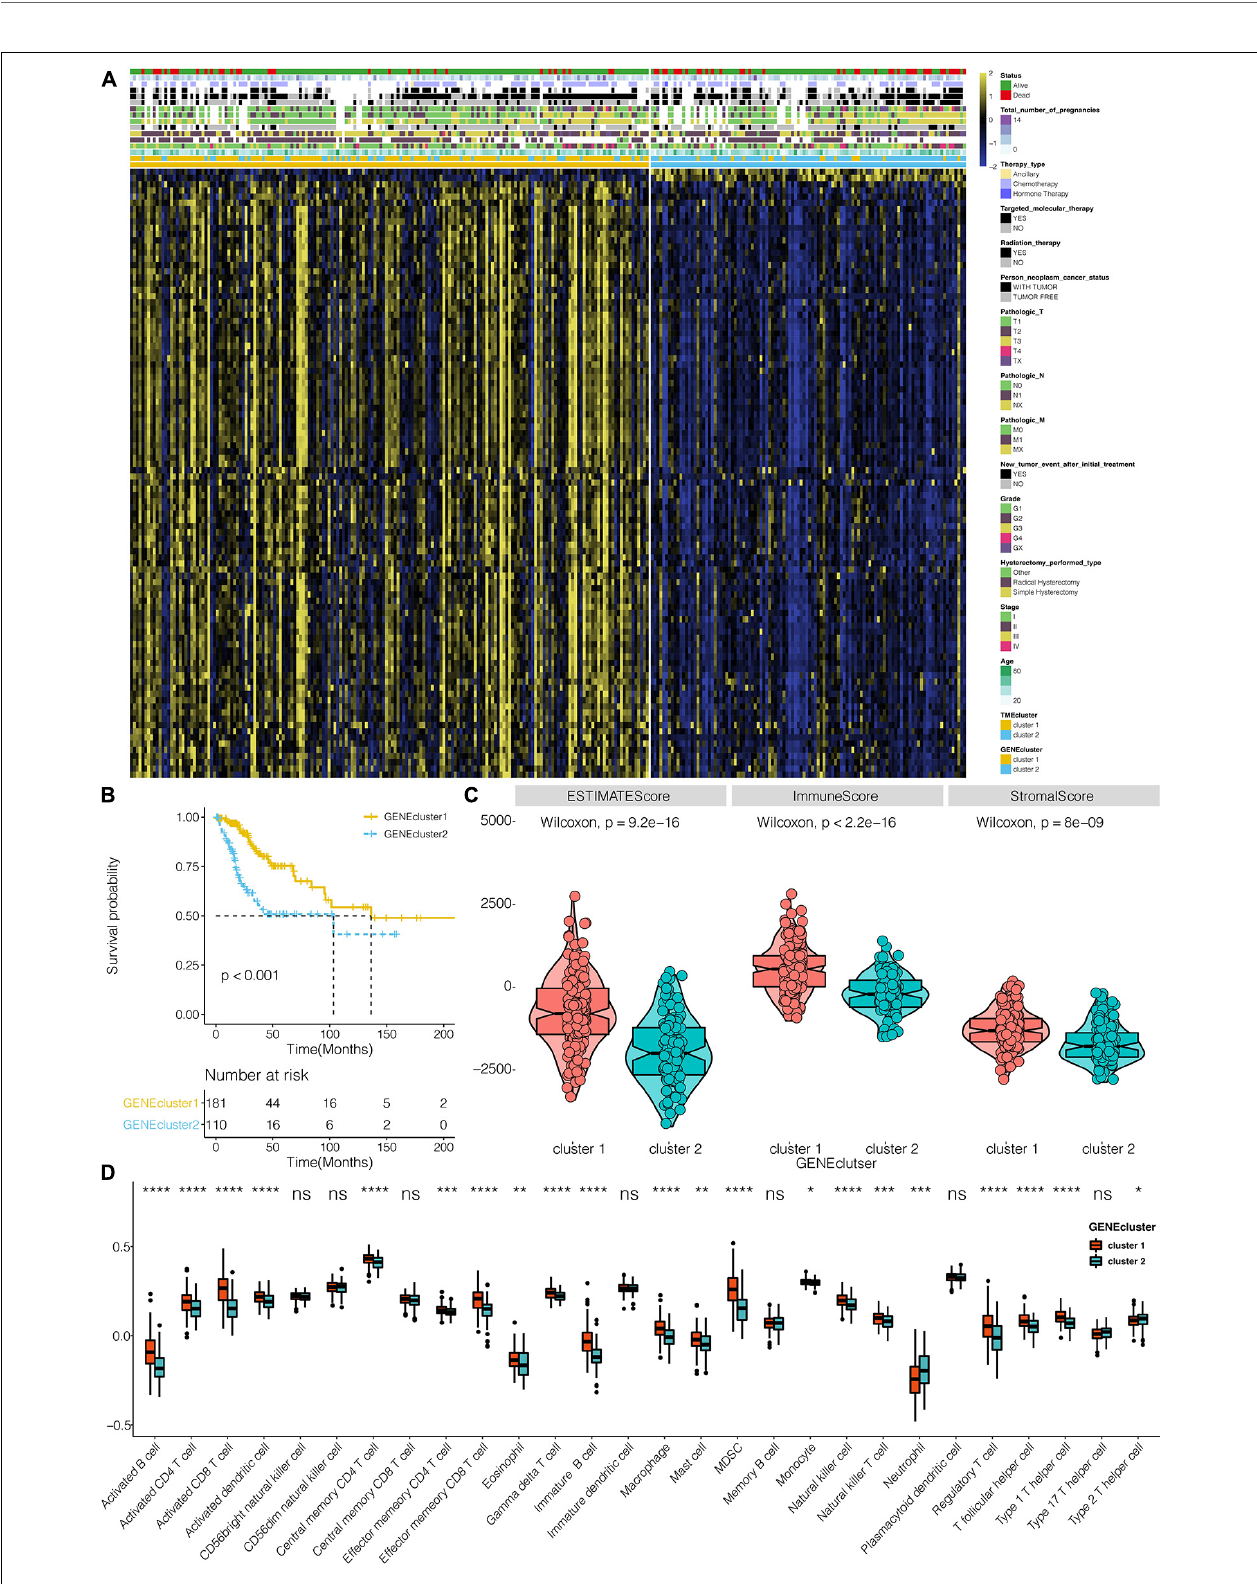
FIGURE 3 | TME signatures and functional annotation constructs. (A) Unsupervised analysis and hierarchical clustering of common DEGs based on expression data of CESC derived from the TCGA: Gene clusters 1 and 2. (B) Kaplan–Meier curves for the two TME gene clusters (log-rank test showed an overall P < 0.001). (C) The differential expression of Estimate, Immune, and Stromal Score in TME clusters in the TCGA dataset. (D) The distribution of cells in TME gene clusters. *, P < 0.05; **, P < 0.01; ***, P < 0.001; ****, P < 0.0001; ns, not statistically significant.